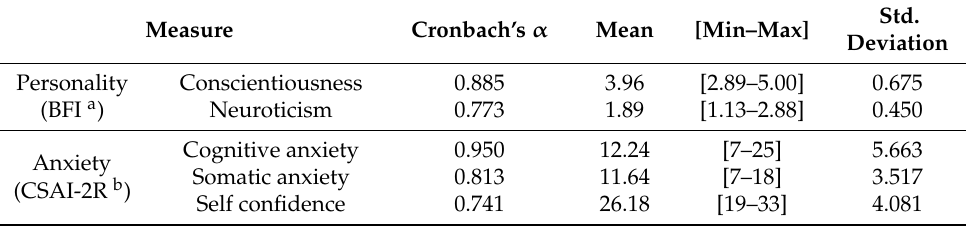
Table 1. Values of the features characterizing individual differences in the present study.